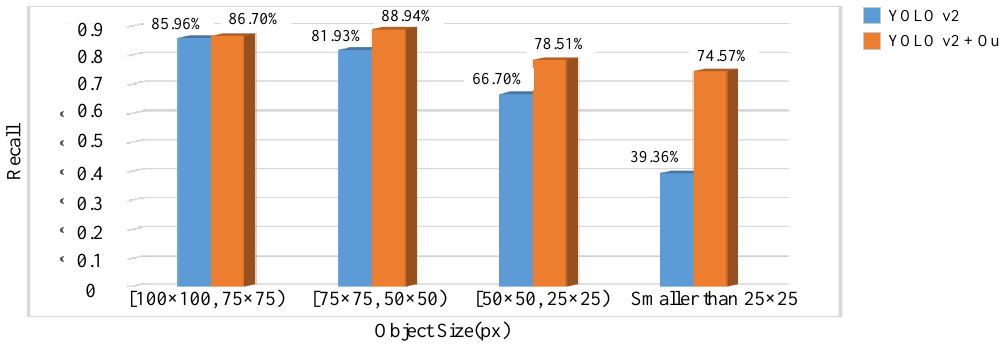
Figure 11. Detection performance with YOLO v2 on different object sizes. With a reduction in target size, the proposed method showed a huge advantage in terms of small target detection as it maintained great precision on objects smaller than 25 ×